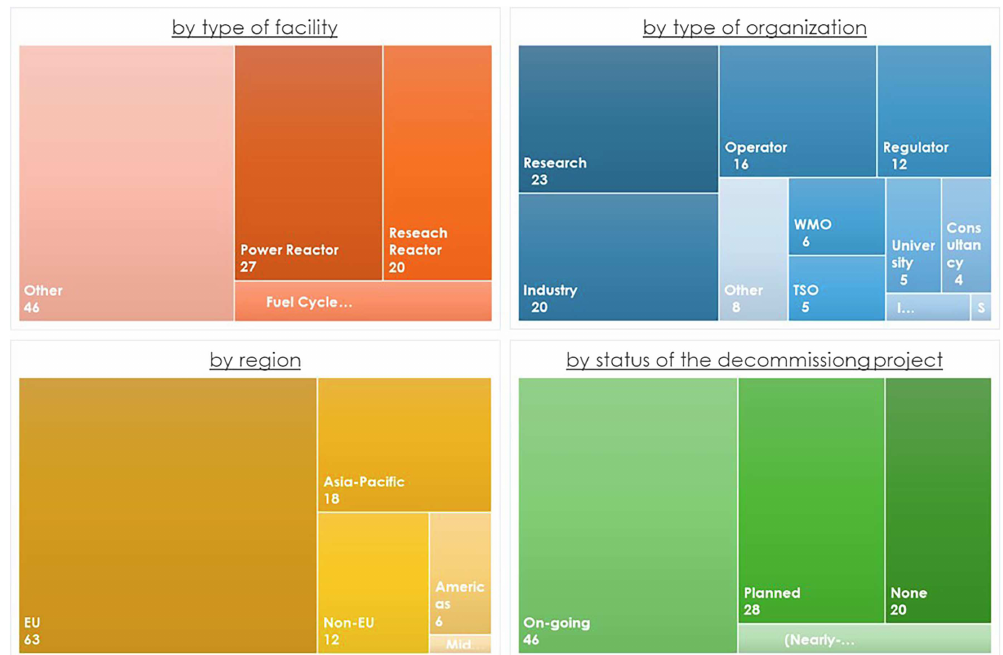
Fig. 6. Profiles of the Stakeholders responding to the questionnaire survey.